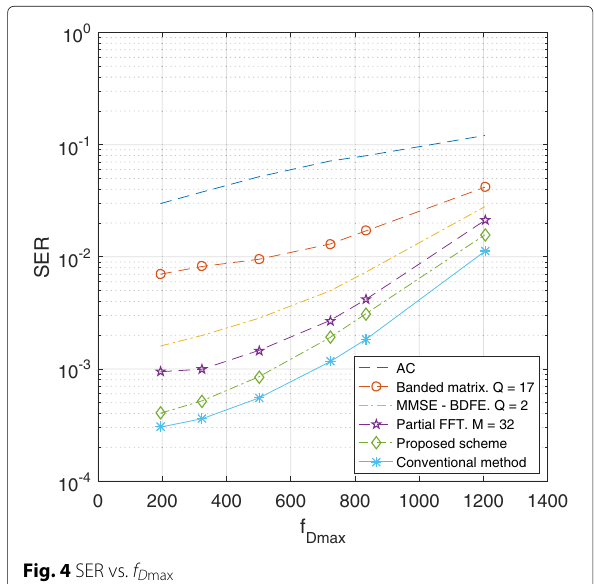
Partial FFT. M = 32 Proposed